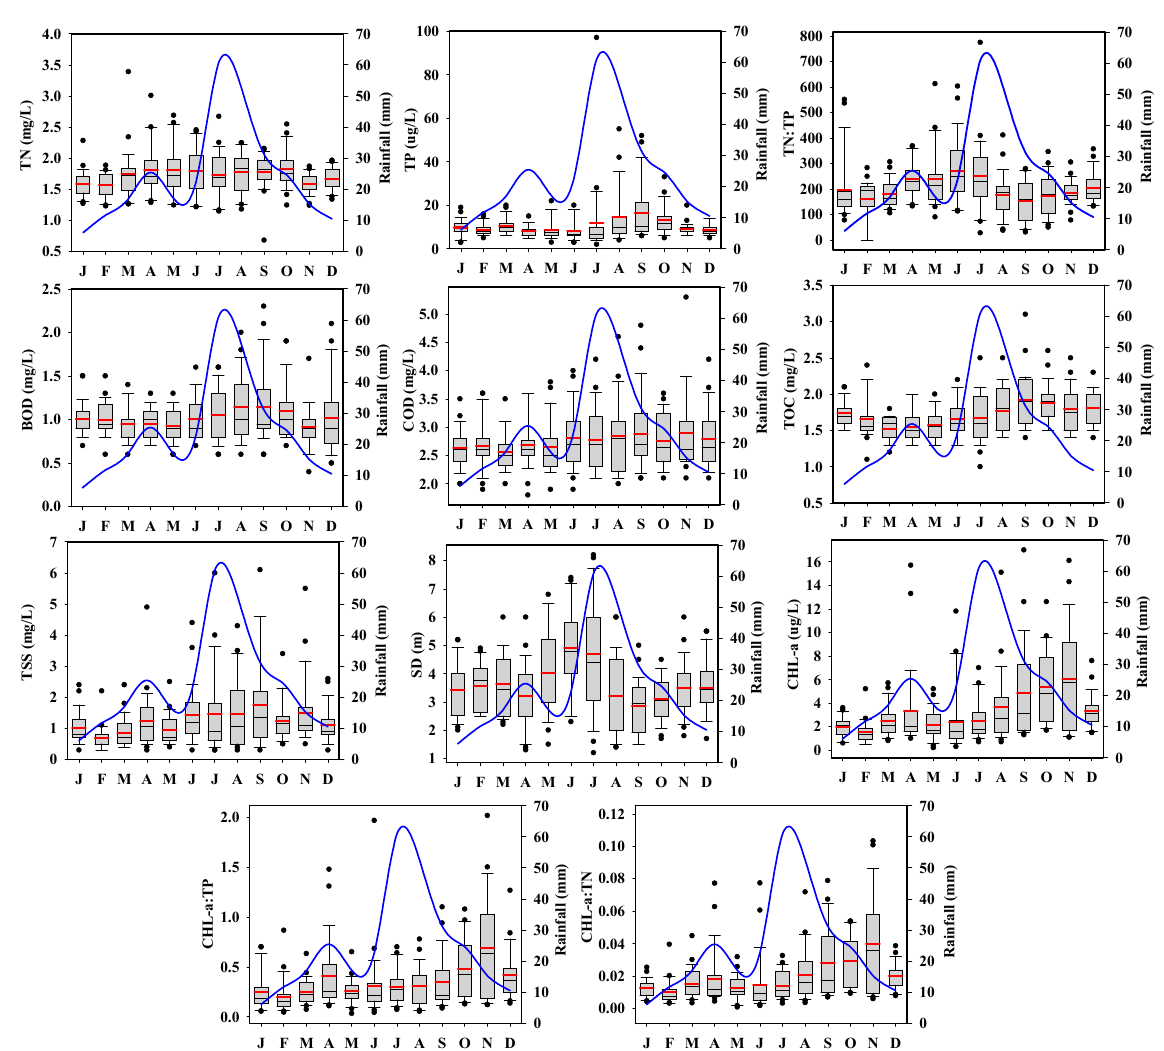
Figure 2. Seasonal trend analysis using the box and whisker plots of nutrients (TP, TN, and their ratio), organic matter (BOD, TOC), total suspended solids (TSS), ambient ratios of CHL-a:TP, CHL-a:TN, and CHL-a (Red line denotes the mean value).